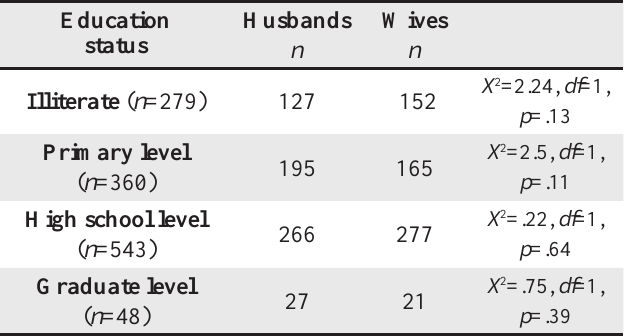
Table 2 : Education status of Husbands and Wives according to level of education